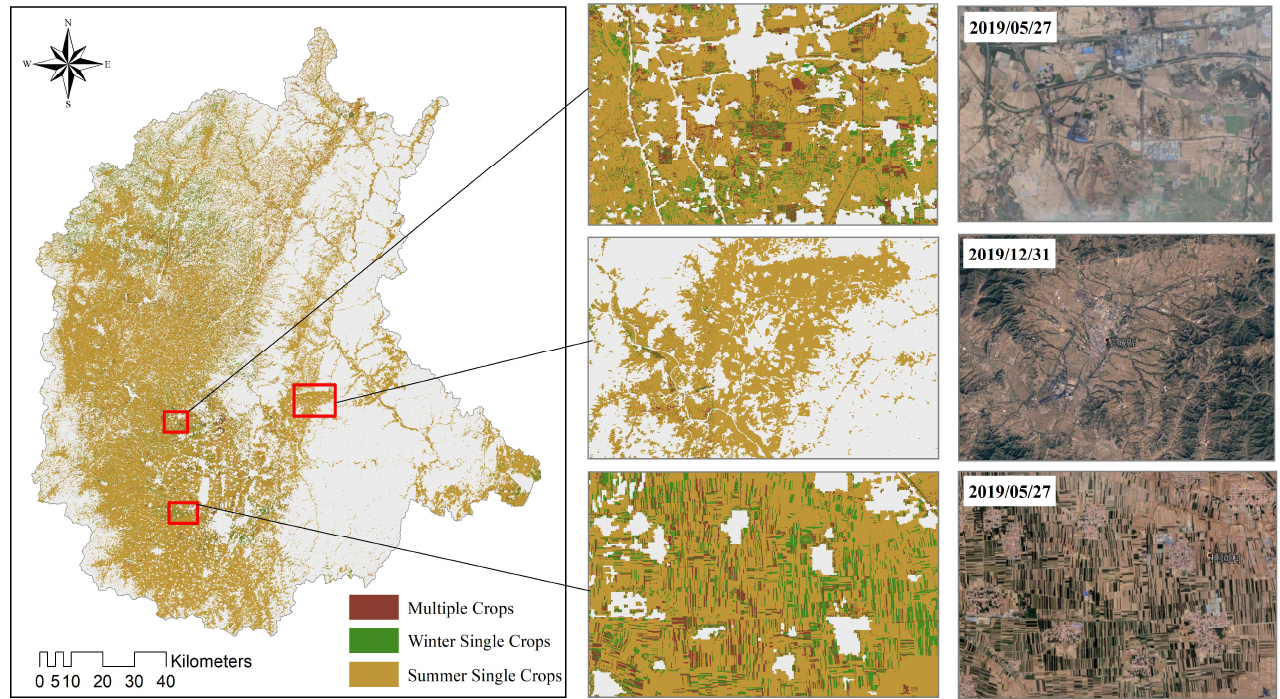
Figure 10. Spatial distribution map of crops in the Yuecheng Reservoir catchment